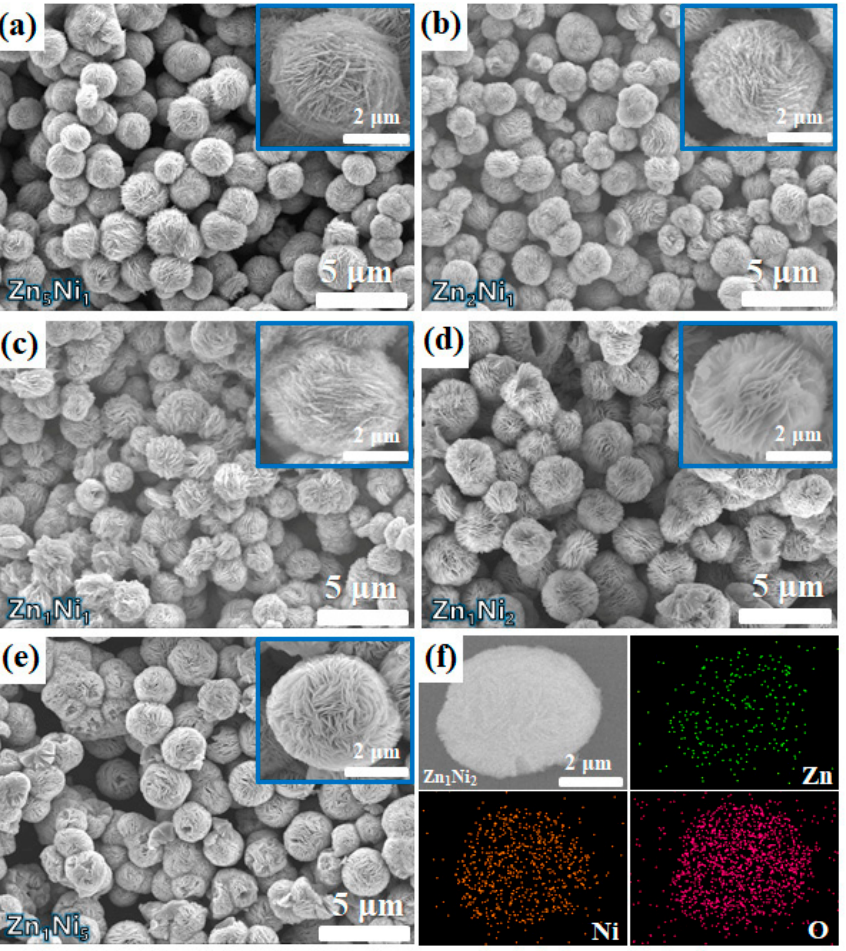
Figure 3. SEM images of as-prepared samples: Zn 5 Ni 1 ( a ), Zn 2 Ni 1 ( b ), Zn 1 Ni 1 ( c ), Zn 1 Ni 2 ( d ) and Zn 1 Ni 5 ( e ). ( f ) The elemental mapping of Zn 1 Ni 2 sample.